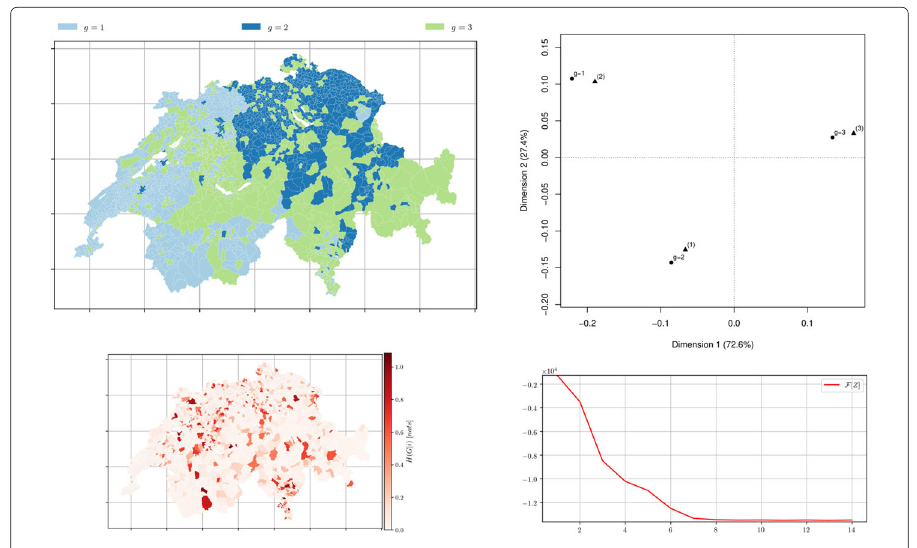
Fig. 8 Municipalitiessoftclusteringonallthetopics depicts the semi-supervised hard assignment obtained from a random membership matrix Z 0 for m = 3 groups using distance matrix D obtained from topic modelling with k = 3 after 14 iterations. Lefttop Hard membership. Leftbottom the conditional entropy of topics H ( R | i ) showing municipality-topic probability distribution uncertainty. Righttop the CA bi-plot between Z ∞ (illustrated by • ) and the official classification (illustrated by (cid:2) ) with m = 3. Rightbottom The free-energy plot: decreases as the number of iterative steps increases ( β = 5, α =